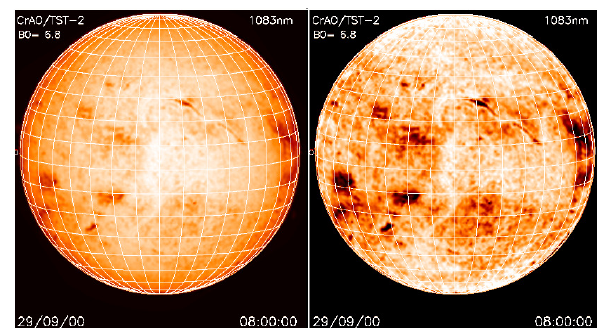
Figure 3. Full-disk images of the Sun obtained on September 29th, 2000 in the He I 1083 nm line (USPh/TST-2)